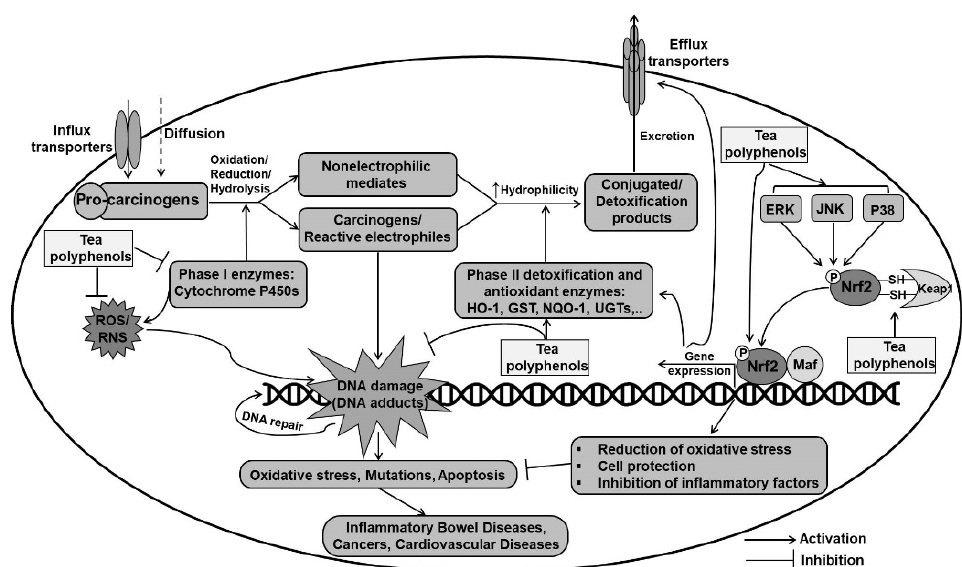
Figure 3. Cytoprotective mechanisms of tea polyphenols via regulation of phase I and phase II enzymes. Keap1, Kelch-like ECH-associated protein 1; maf, Musculoaponeurotic fibrosarcoma; Nrf2, Nuclear factor erythroid 2-related factor 2; HO-1, Heme oxygenase-1; NQO1, NADPH:quinone oxidoreductase 1; GST, Glutathione transferase; ERK, Extracellular signal-regulated kinase; JNK, c-Jun N-terminal kinase; UGTs, UDP-glucuronosyltransferases.